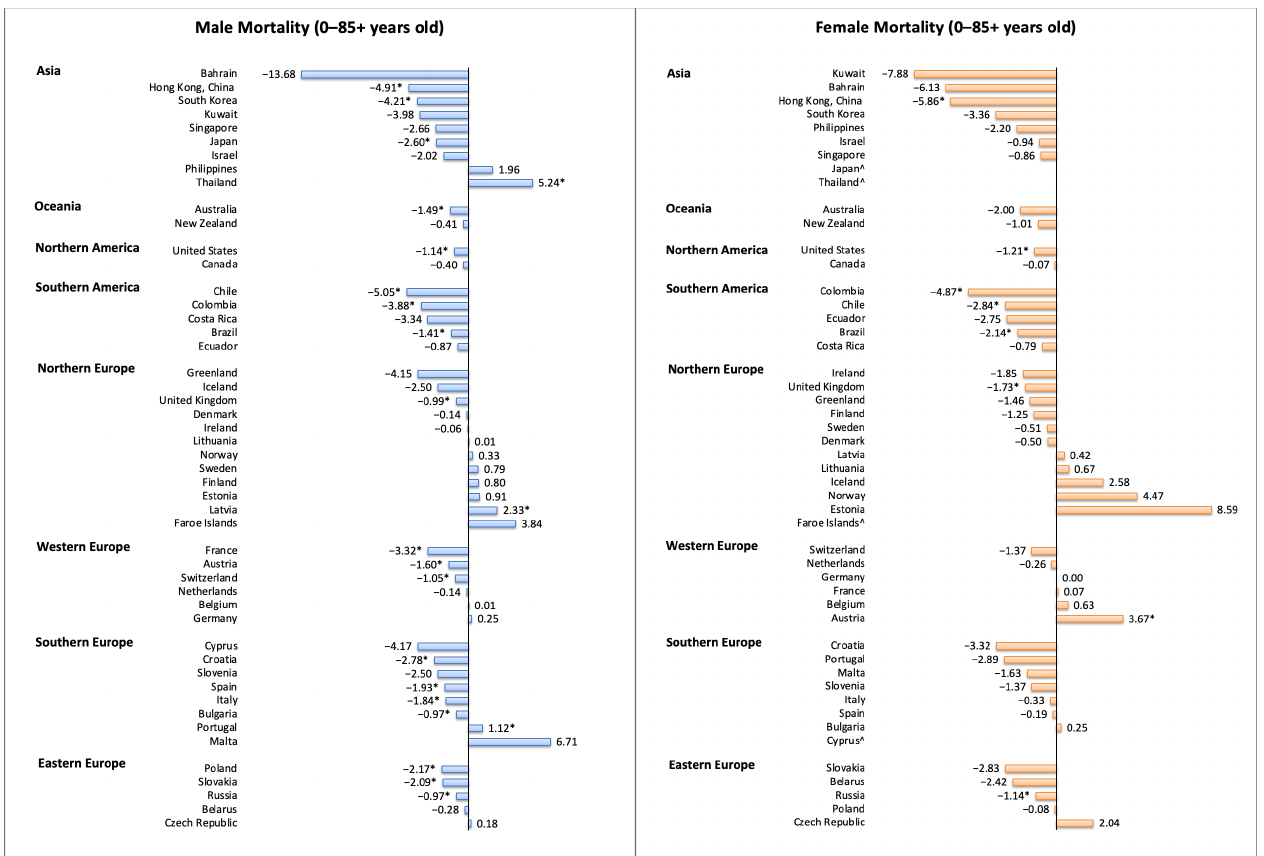
Figure 5. The AAPC of the mortality of esophageal cancer in individuals aged 0–85+ years. AAPC, annual percentage change; * p values less than 0.05; ˆ AAPC for these countries could not be generated, as zero or missing values were identified in any year of trend analysis; the 95% confidence intervals and p values for the tests of AAPC are presented in Table